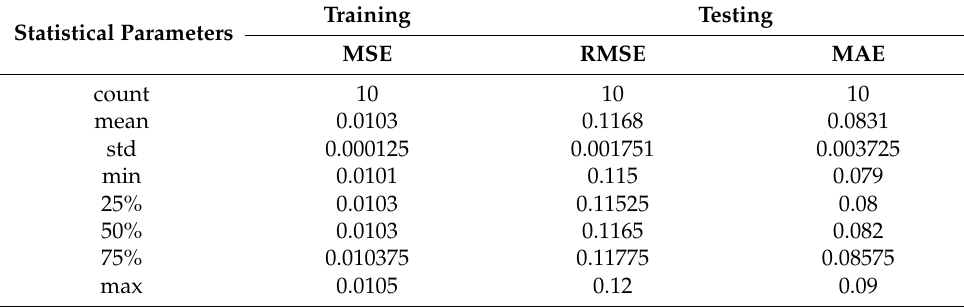
Table 6. Statistical performance of the model (RHM-1).